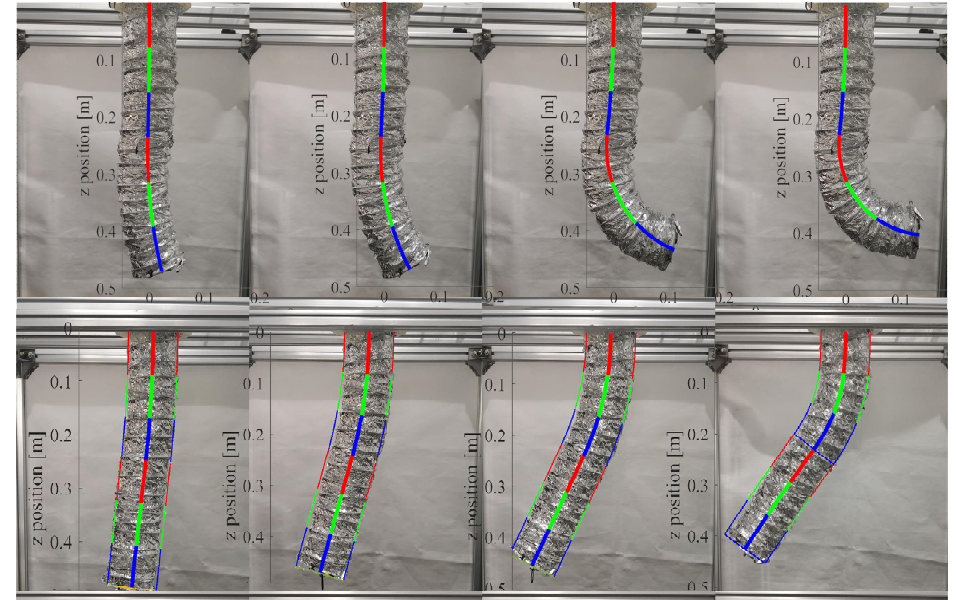
Figure 10. The steady state posture of the soft manipulator under different driving pressures.